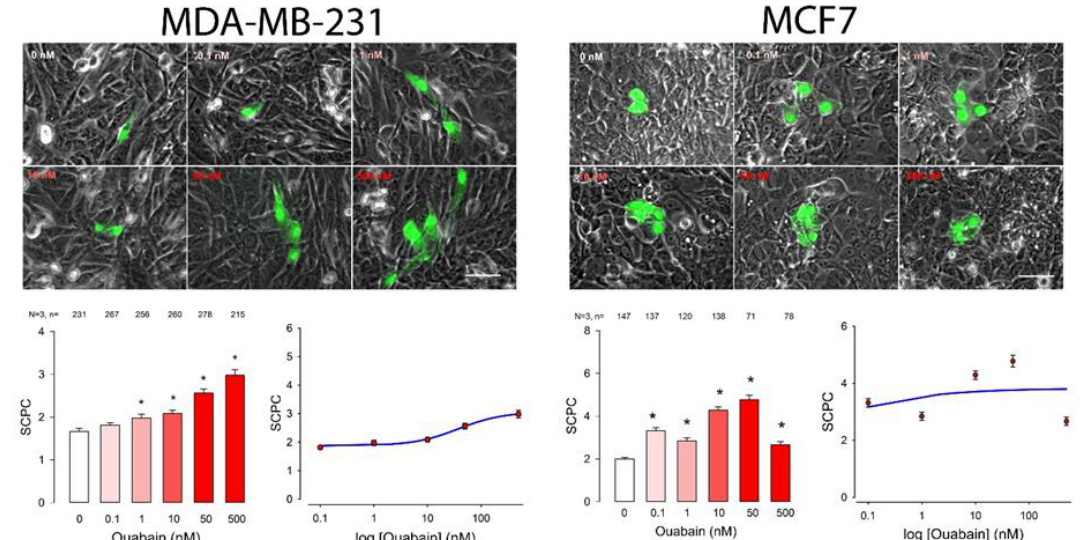
Figure 2. Effect of ouabain on GJIC of breast cancer cell lines (MDA-MB-231 and MCF7). Each set shows, in the top part: representative images comparing the number of stained cell per cluster (SCPC) after one of them had been injected with Lucifer Yellow in monolayers that were either untreated (0 nM) or treated for one hour with ouabain in the concentration indicated (nM). In the bottom part: ( Left ) Histogram showing mSCPC (± SE) in monolayers of confluent cells that were treated with ouabain, for one hour, in the concentrations indicated at the bottom of the bars. At the top of each bar the number of repeats after three independent trials is shown. Asterisks indicate a statistically significant difference compared to the control group, (Dunn’s method), * indicates p = < 0.05. Scale bar length = 100 µM. ( Right ) A semi-log plot shows, the average data and the curve (blue) resulting after fitting data to a logistic equation.